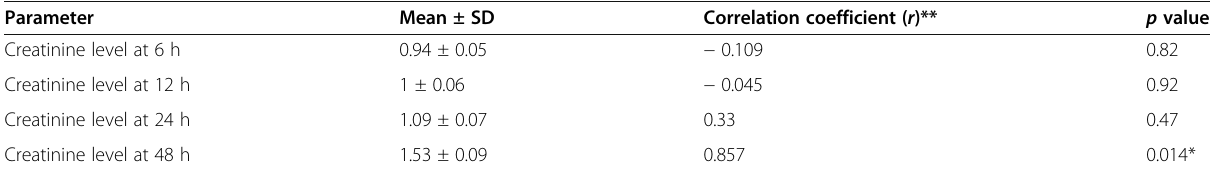
Table 3 Correlation between serum NGAL 6 h postoperative and change in creatinine in the AKI group after 2 days in the AKI group